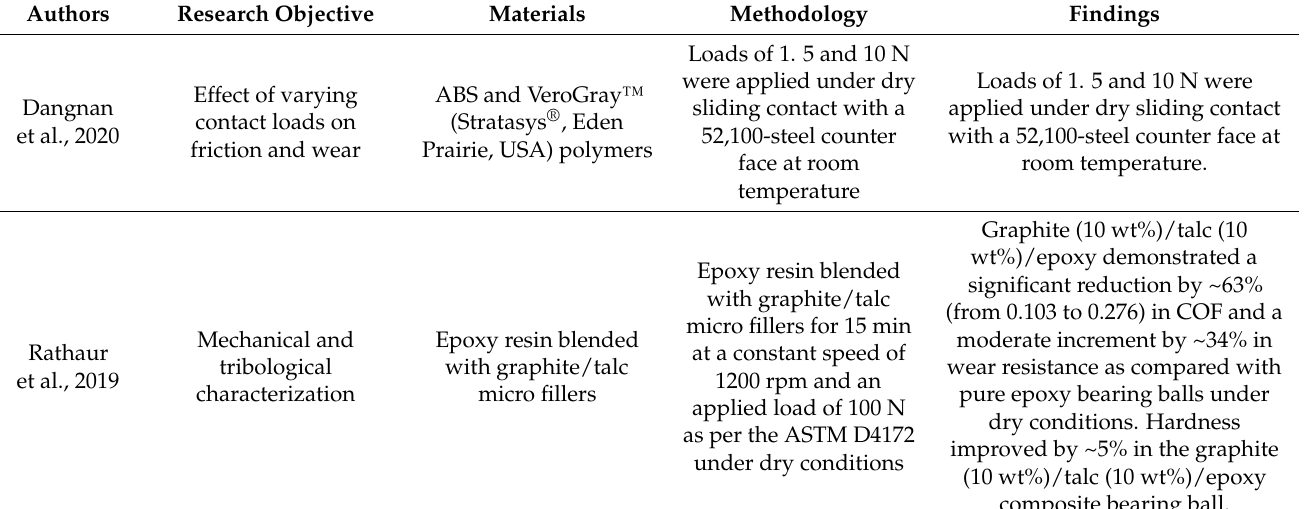
Table 1. A summary of studies on the tribological properties of polymers, testing methods, and